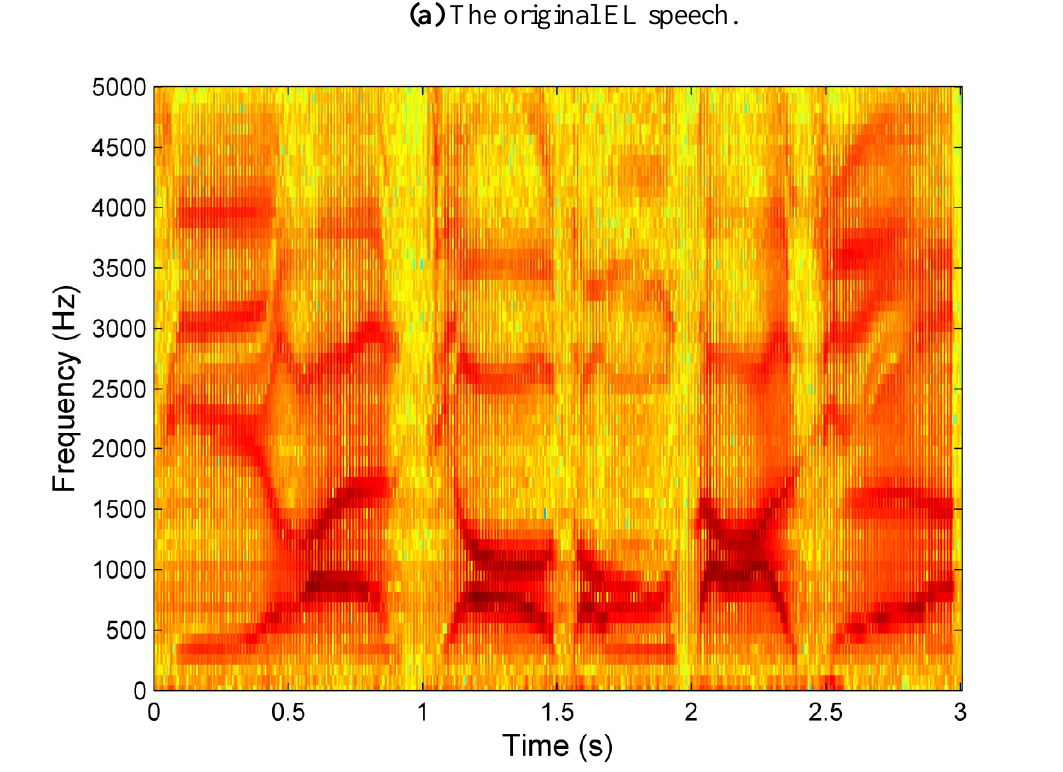
Figure 3. Spectrogram of the sentence “Xi An Jiao Tong Da Xue”. (a) The original EL